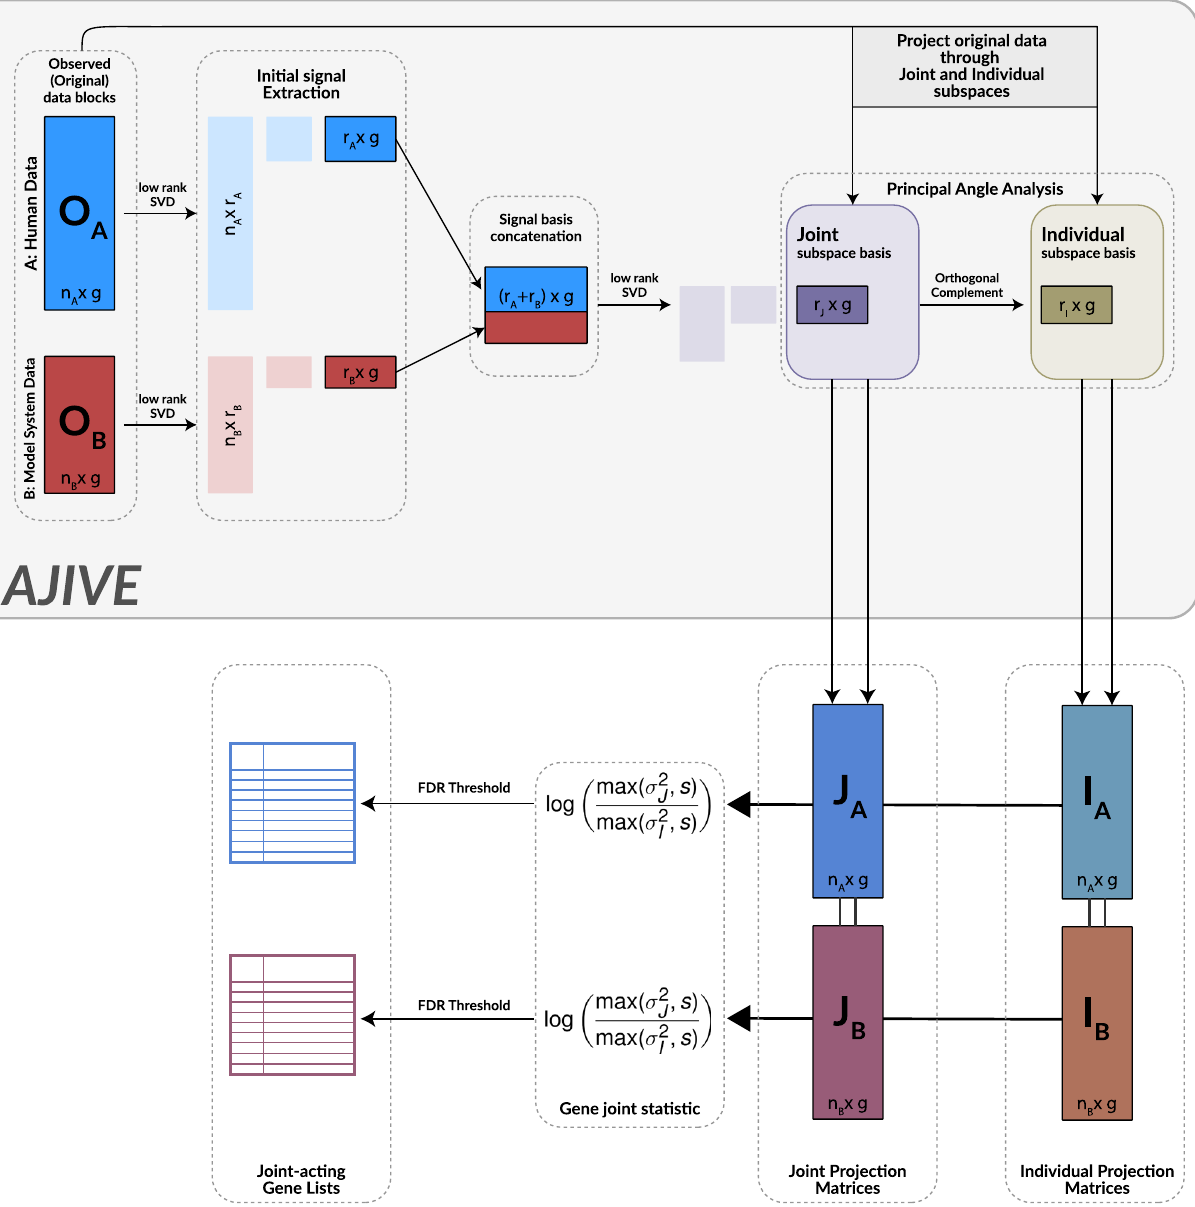
Fig. 1 Schematic of joint dimension reduction cohort integration using AJIVE. Human and model system input data are integrated across the gene axis to produce joint and individual projection matrices used in downstream analysis. The original input datasets ( O A , O B ) are decomposed through an initial low- rank SVD using a set initial rank parameter ( r ) that removes residual (i.e., noise) variation. Selection of this parameter is detailed in the Methods section. Right singular vectors are then concatenated. Principal angle analysis is performed through an additional SVD step that identi fi es a “ Joint ” subspace basis consisting of signi fi cant joint-acting components in addition to a corresponding “ Individual ” subspace basis that consists of input dataset-speci fi c components. The original input data are reprojected through these bases to produce Joint ( J A , J B ) and Individual ( I A , I B ) projection matrices. By calculating a joint statistic for each gene in the projection matrices, we can then identify signi fi cantly joint-acting genes across both